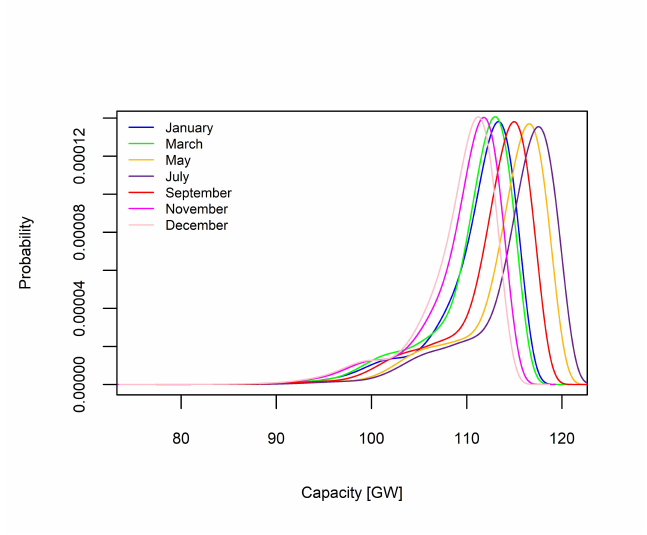
Figure 2. Graph representation of COPT for 2019 for the first day of the selected months.